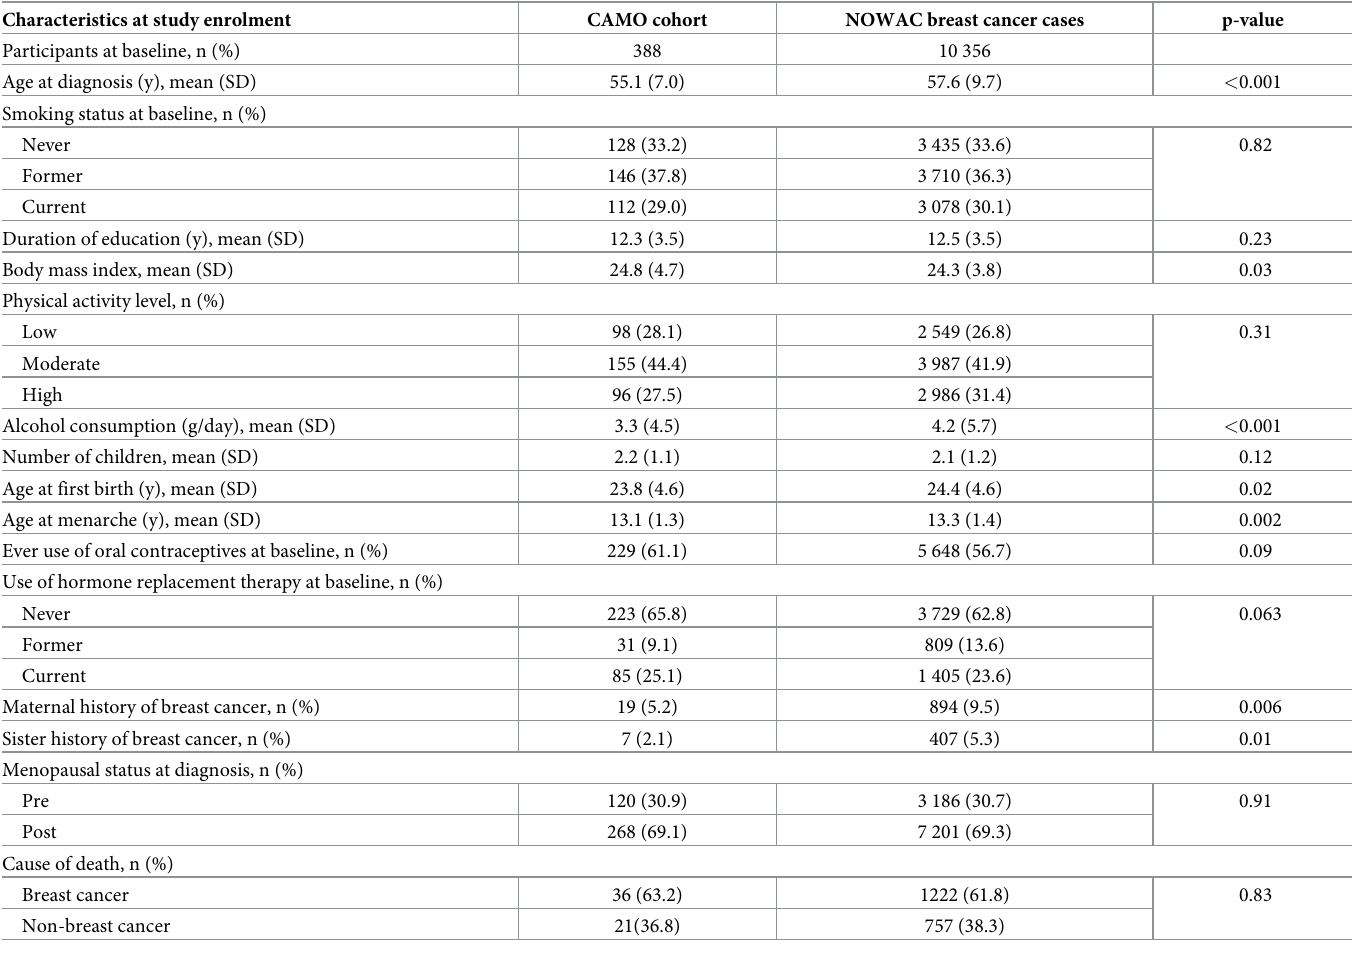
Table 2. Comparison of selected characteristics between the study populations of CAMO (n = 388) and NOWAC breast cancer cases (n = 10 356). Characteristics at study